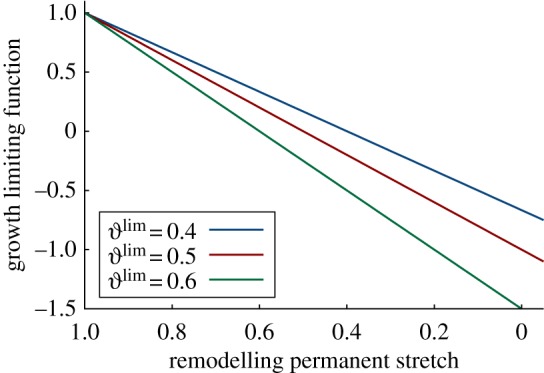
The variation of the remodelling permanent stretch limit ϑlim changes the slope of the growth-limiting function f(ϑ).